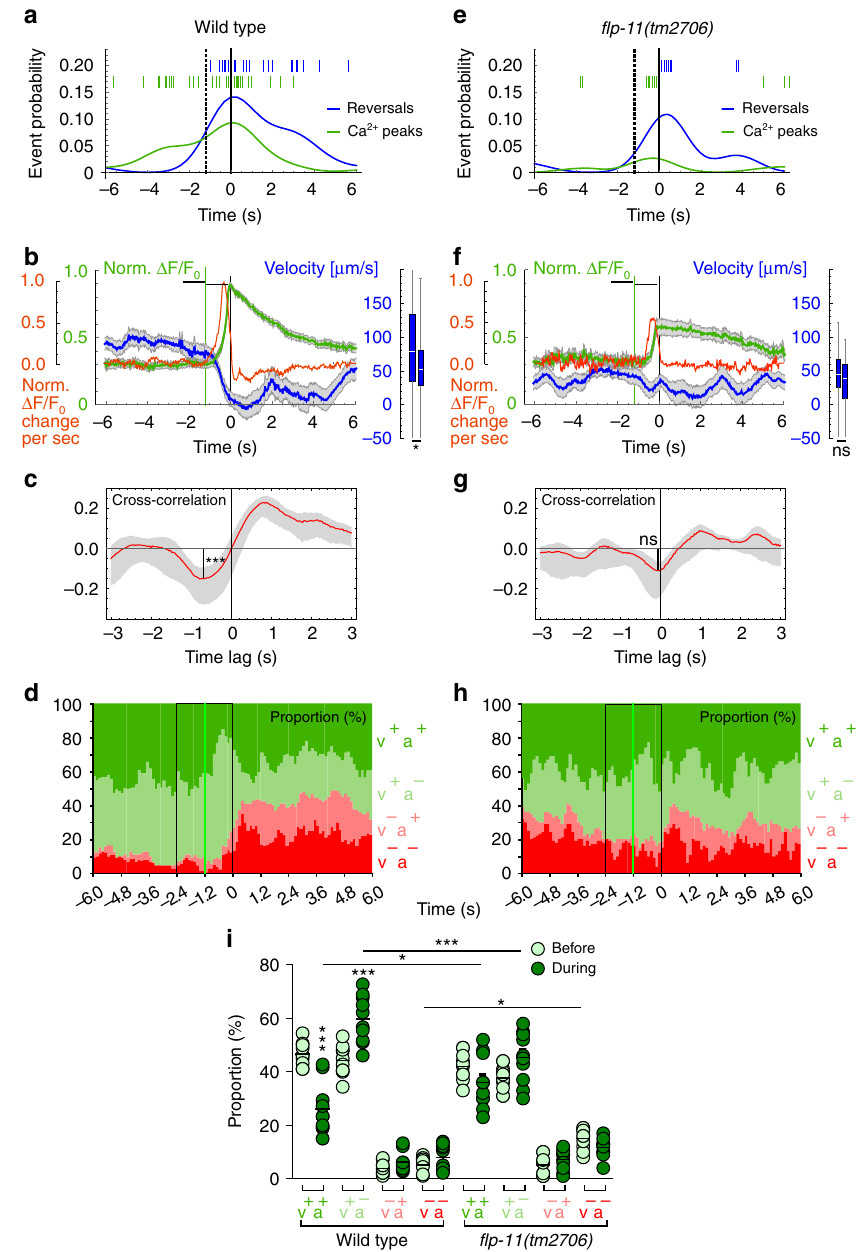
Fig. 6 RIS Ca 2 + activity induces decreased forward locomotion and increased reversal probability, which requires FLP-11 neuropeptides: a Conditional probability density function of the shortest unbiased time lag to a reversal given a Ca 2 + peak event (aligned nearest reversal events depicted as blue lines) and vice versa for the probability of a Ca 2 + peak event given a reversal (green lines: time lag to the nearest reversal) in WT animals. The dotted vertical line indicates the mean onset of a Ca 2 + rise, the black solid line indicates peak Ca 2 + . b Ca 2 + peak-aligned normalized GCaMP intensity (green, mean ± SEM) in the nerve ring region of the RIS axon (as depicted in Fig. 4c) and animal velocity in µ m/s (blue, mean ± SEM, n = 45; a signi fi cant reduction in the two periods before and during the Ca 2 + rise is shown on the right, boxplot, p < 0.001). Shown in red is the mean fi rst derivative (d F /d t rise rate, s − 1 ) of all Ca 2 + signals. c Mean ± con fi dence intervals of time-shifted cross-correlation (red) of animal velocity aligned to Ca 2 + signal rise rate, (as in b ). Anticorrelation is signi fi cantly different from 0 and shows a negative time lag ( n = 45, Pearson ’ s r = − 0.15). d Ca 2 + peak-aligned analysis of the proportion of the animal population in one of the four behavioral states: 1 moving forward and accelerating (v + a + , positive velocity and acceleration, dark green; for acceleration data, see Supplementary Fig. 6C, D), 2 moving forward and decelerating (v + a − , light green), 3 moving backwards, but accelerating (v − a + , pink), and 4 moving backwards and slowing (v − a − , dark red). Number of reversing animals increased signi fi cantly during RIS Ca 2 + events ( T test, p < 0.001). Green line indicates mean onset of RIS Ca 2 + rise. i Scatter plot with means of the data in d , h ; statistical differences analyzed for the time periods indicated by black boxes (before and during Ca 2 + rise). e – h As in a – d , but in fl p-11(tm2706) background. Boxplots in b , f compare the average in the time windows indicated by black brackets below the traces. *** p ≤ 0.001; * p ≤ 0.05; ns: not signi fi cant; statistical signi fi cance tested by paired T test in b , f and unpaired T test in c